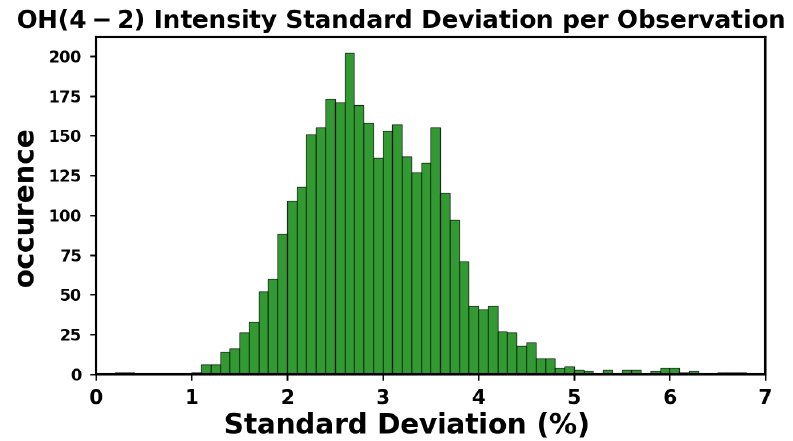
Figure A1. Standard deviation per observation of the OH ( 4 − 2 ) emission intensity for the APOGEE data set.